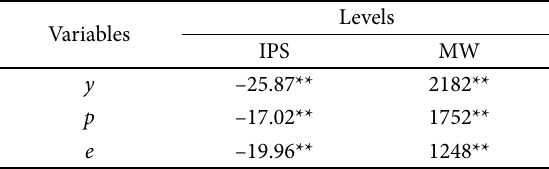
Table 1. Panel unit root tests